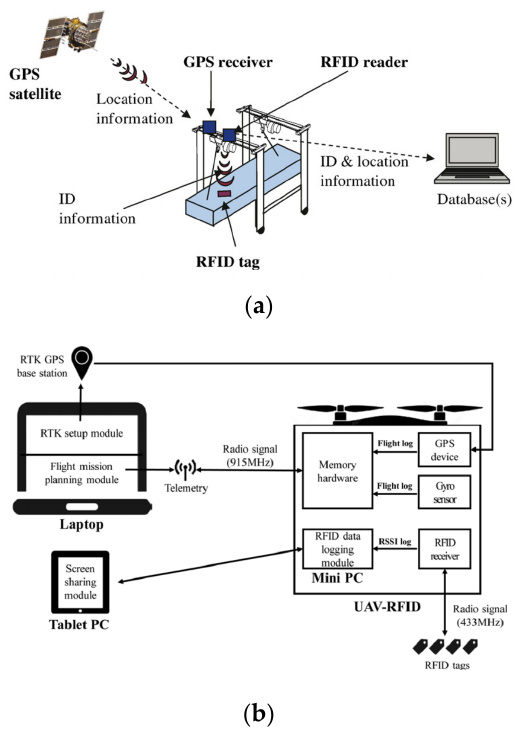
Figure 13. ( a ) Automation elements tracking and locating in storage [157]; ( b ) UAV-RFID system signal processing flow chart [158].